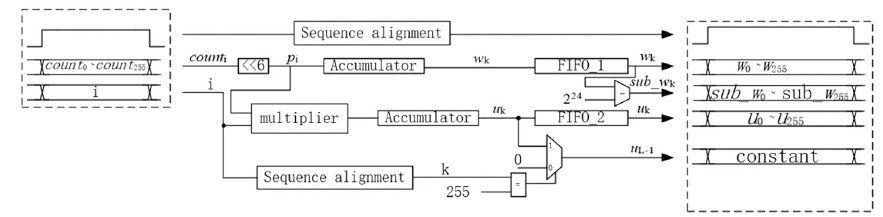
Figure 13. Architecture of Otsu’s algorithm calculation.